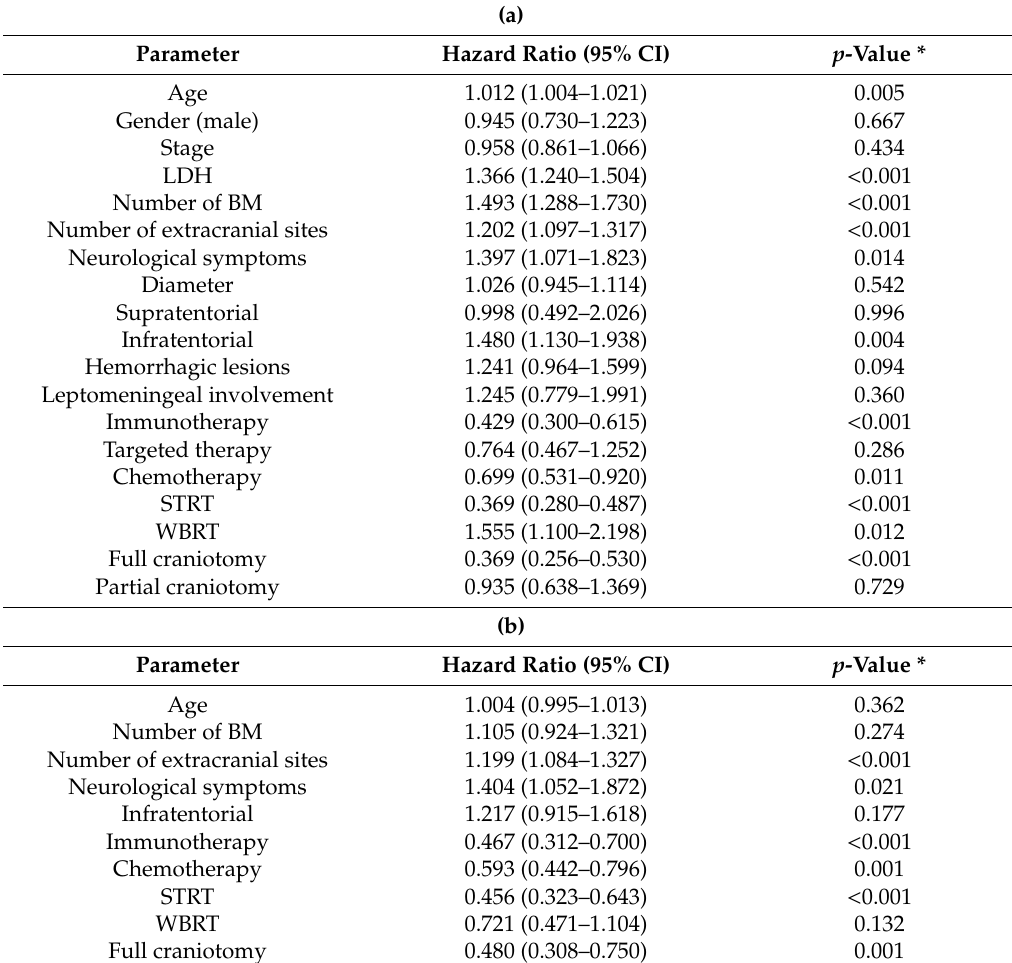
Table 2. Impact of clinical and treatment parameters on overall survival using the proportional Cox hazards model: ( a ) univariable analysis; ( b ) multivariable